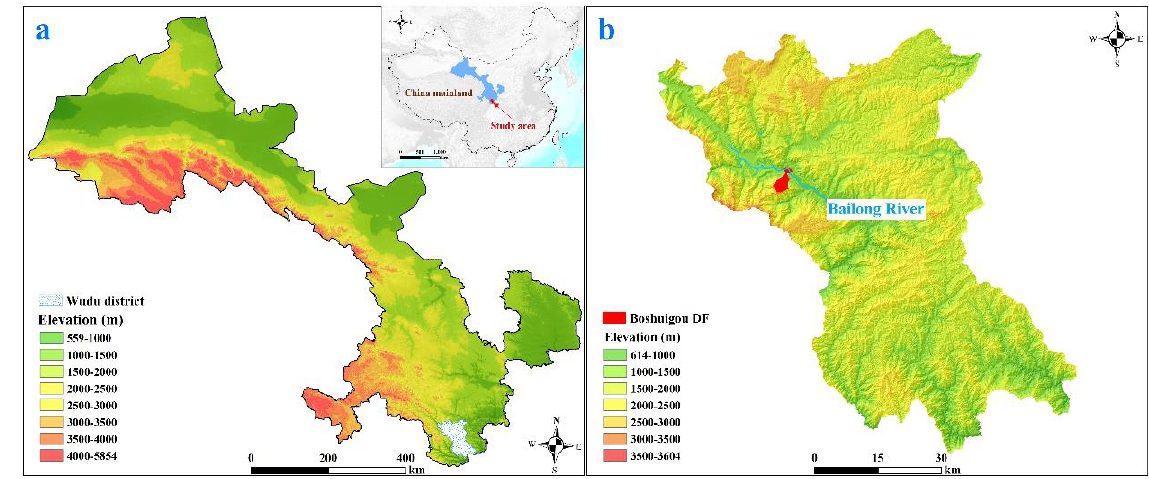
Figure 1. Location ( a ) and topography ( b ) of the Boshuigou debris flow and its vicinity.